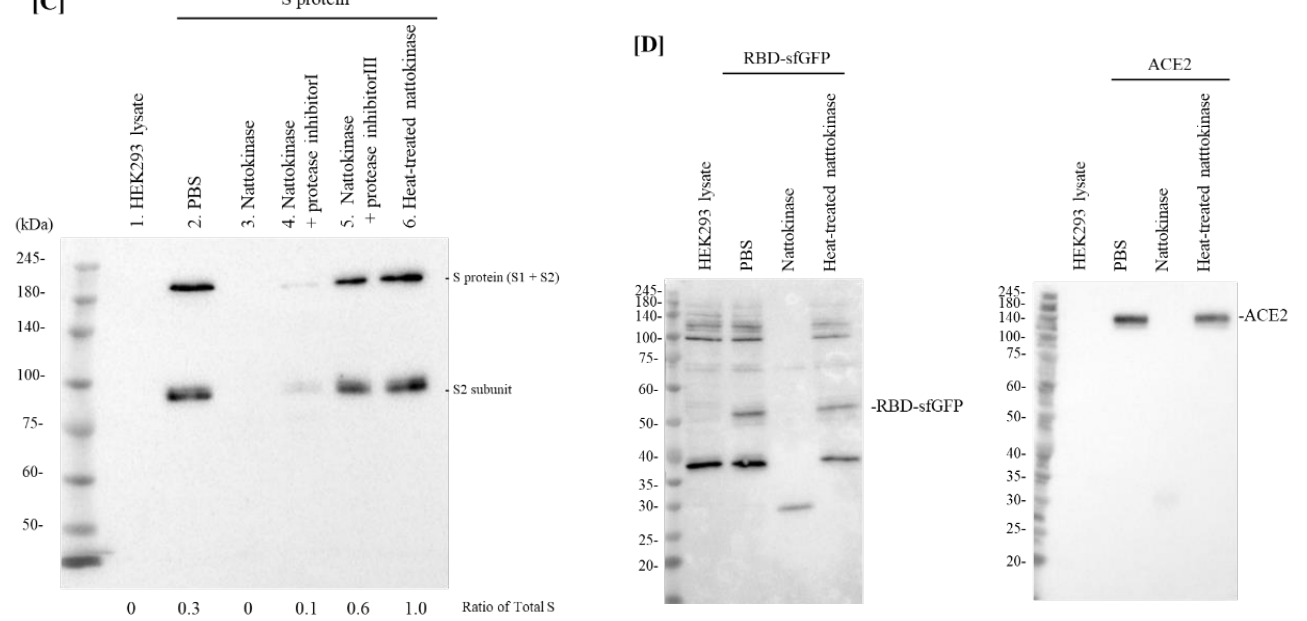
Figure 1. ( A ) Degradative effects of nattokinase in dose-dependent manner. Serial diluted nattokinase (32 µ g/mL, 8 µ g/mL, 2 µ g/mL, 500 ng/mL, 125 ng/mL, 31.25 ng/mL, and 7.8125 ng/mL) were mixed with S protein expression cell lysate and incubated. Full length of S protein (S1 and S2 subunits) and S2 subunit were detected as upper and lower bands, respectively. Ratio of total S was indicated as the relative quantity of S protein (S protein + S2 protein). ( B ) Degradative effects of nattokinase in time-dependent manner. S protein expression cell lysate was incubated with 1 µ g/mL nattokinase for 0, 10, 30, 60, 120, and 180 min. ( C ) Effects of heating treatment or protease inhibitors. Lane 1: HEK293 lysate; lane 2: HEK293 lysate (S protein); lane 3: HEK293 (S protein) + nattokinase (5 µ g/mL); lane 4: HEK293 (S protein) + nattokinase (5 µ g/mL) + Protease inhibitor I; lane 5: HEK293 (S protein) + nattokinase (5 µ g/mL) + Protease inhibitor III; lane 6: HEK293 (S protein) + heat-treated nattokinase (5 µ g/mL). ( D ) Degradative effect on RBD of S protein and ACE2. RBD of S protein and ACE2 coding plasmids were transfected with HEK293 cells, respectively. Cell lysates were incubated with nattokinase (7.5 µ g/mL) and heat-treated nattokinase (7.5 µ g/mL) and Western blotting was